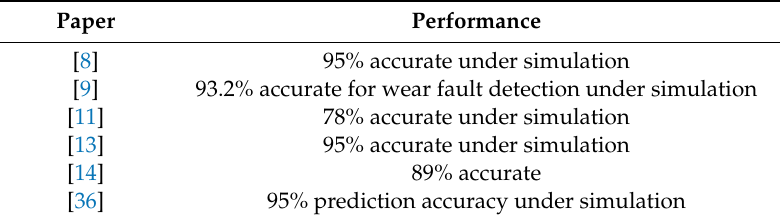
Table 2. Comparison of performance with existing